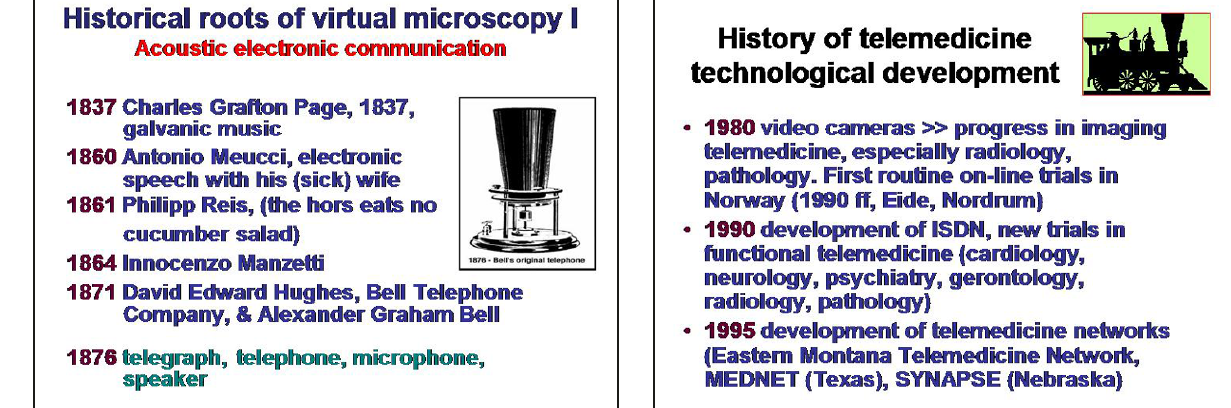
Figure 1 Historical roots of virtual microscopy related to acoustic electronic communication .